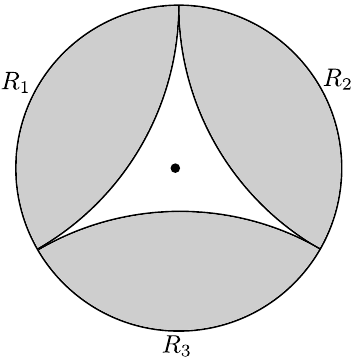
Figure 4 . The simplest example of holographic quantum error correction: splitting a single AdS boundary into three regions R 1 , R 2 , and R 3 [33]. The white triangular region in the center is an \island" in the same sense as the bodies of the octopi in (cid:12)gure 2: it can be accessed from any two of the boundary regions but not from any one. For example if we compare R 1 and R 2 to the \Hawking radiation" CFTs and R 3 to the remaining \black hole" CFT, we can view this as a model for an evaporating black hole after the Page